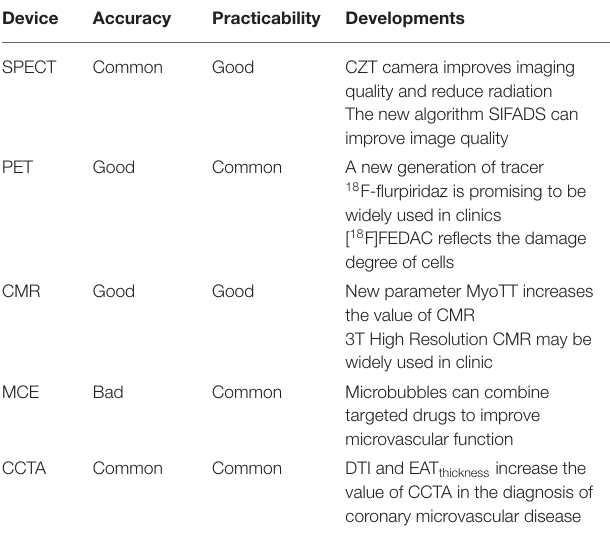
TABLE 2 | Characteristics of various imaging methods for microvascular angina.